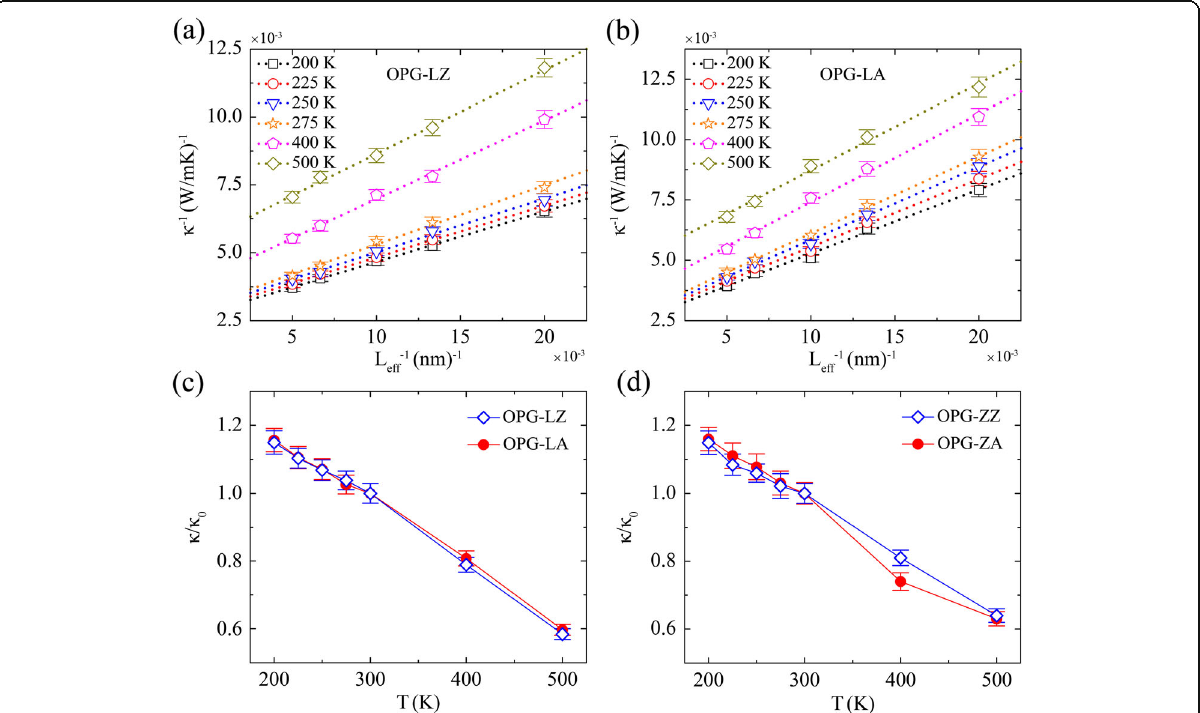
Fig. 8 Inverse TC of a OPG-LZ, b OPG-LA at various temperatures as a function of the inverse sample length, and the relative TC ( κ / κ 0 ) of c OPG-L and d OPG-Z as a function of temperature. κ 0 is the TC at 300 K, which is 310 W/mK, 332 W/mK, 247 W/mK, and 227 W/mK for κ OPG-LZ , κ OPG-LA , κ κ OPG-ZZ , and OPG-ZA ,